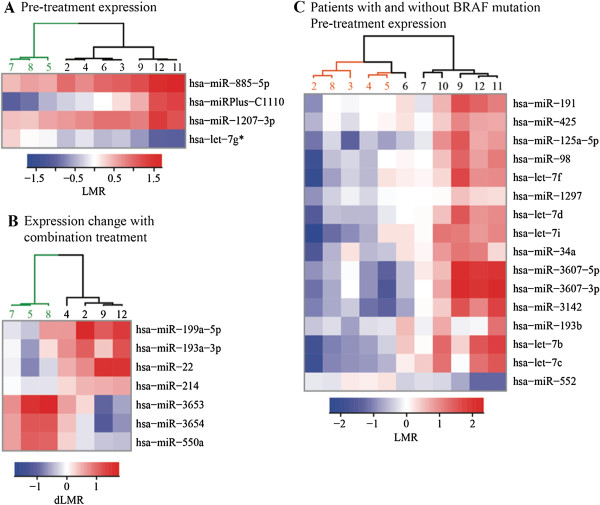
Clustering analysis of miRNA expression according to clinical outcome and BRAF tumor status. The heat map illustrates the result of the two-way hierarchical clustering of pre-selected miRNAs and samples. The color scale illustrates the relative expression level or changes in expression level across all samples: red color represents an expression level above the mean and blue color represents expression lower than the mean. Patients #5, 7, and 8 had progressive disease (PD), patient #6 and 9 had partial responses (PR), and the remaining patients had stable disease (SD). (A) Clustering was performed with pre-treatment expression values (LMRs) for miRNAs with t-test p-value < 0.01 and effect size > 0.5. (B) Clustering was performed with changes in miRNA expression (dLMRs) with combination treatment for miRNAs whose t-test p-value < 0.04 and effect size > 0.5. (C) Clustering was performed with pre-treatment expression values (LMRs) for miRNAs whose t-test p-value < 0.02 and effect size > 0.5, using p-values obtained from two-tailed t-tests comparing the average expression level for patients with BRAF mutant melanomas (in orange) with those who had wild-type BRAF melanomas.